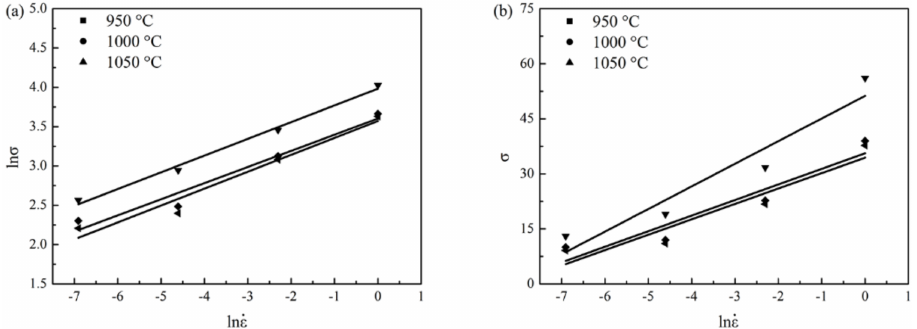
. ε . ε and ( b ) σ —ln in 950–1050 ◦